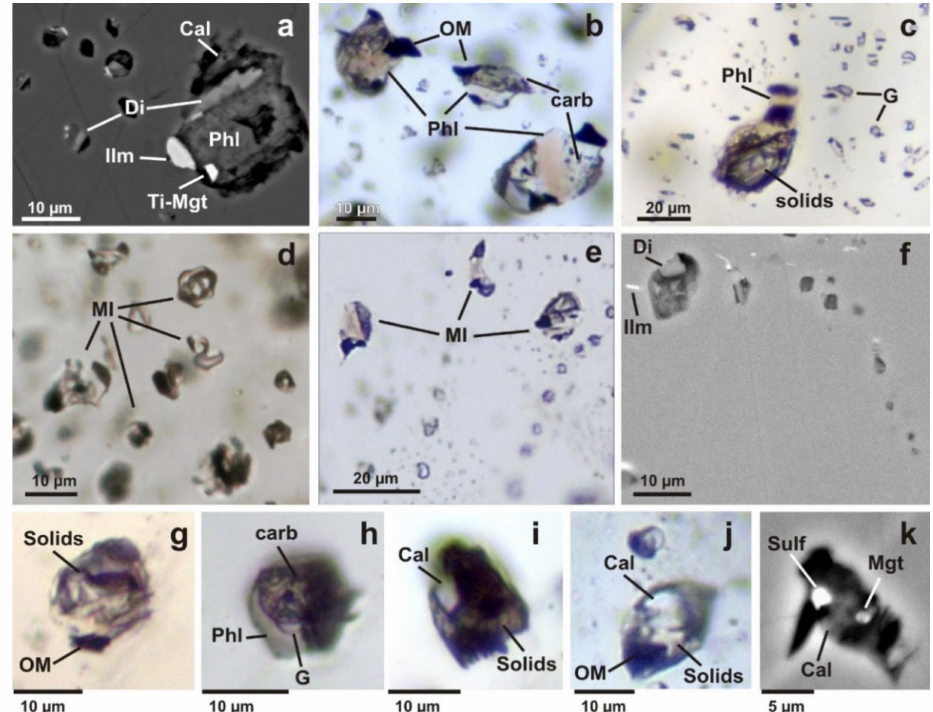
Figure 7. Microphotographs of secondary melt inclusions in olivine macrocrysts in BSE ( a , f , k ) and transmitted light ( b – e , g – j ). ( a ) Opened melt inclusions of different sizes with similar mineral compositions: phlogopite (Phl), calcite (Cal), diopside (Di), ilmenite (Ilm), and Ti-rich magnetite (Ti-Mgt); ( b ) non-opened melt inclusions with well-diagnosed phlogopite, several opaque phases (OM), and a mixture of Ca-Na carbonates; ( c ) relatively large inclusion, with a noticeably larger amount of solid phases (solids) than in small inclusions, located in the same plane in which a gas bubble is well characterized; ( d – f ) chains of melt inclusions of various shapes and sizes; ( g – j ) non- opened melt inclusions with different solid-phase ratios; ( k ) an opened inclusion containing calcite, sulfides (pentlandite and pyrrhotite) and